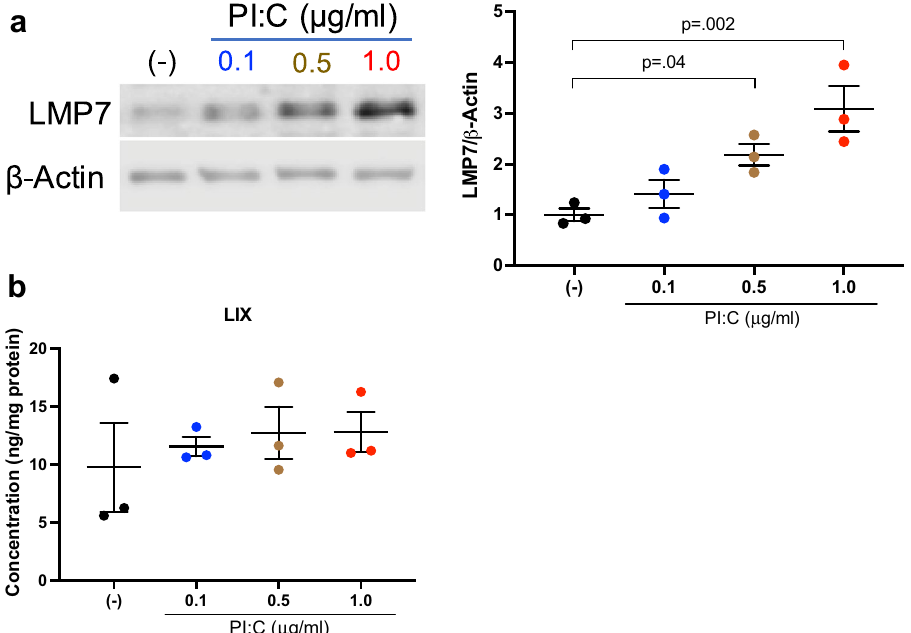
Figure 3. PI:C (1 µg/ml) upregulates LMP7 expression with minimal pro-inflammatory effects in cultured mouse tracheal epithelial cells (mTECs) . mTECs (n = 3 independent experiments) in submerged culture were stimulated with different doses of PI:C (0.1, 0.5, 1.0 μg/ml) or medium control (−) for 24h. ( A ) Representative western blot image and densitometry of LMP7 protein. ( B ) LIX levels in the supernatant were normalized to total protein in the cell lysate. Data were analyzed using one-way ANOVA with Holm–Sidak’s